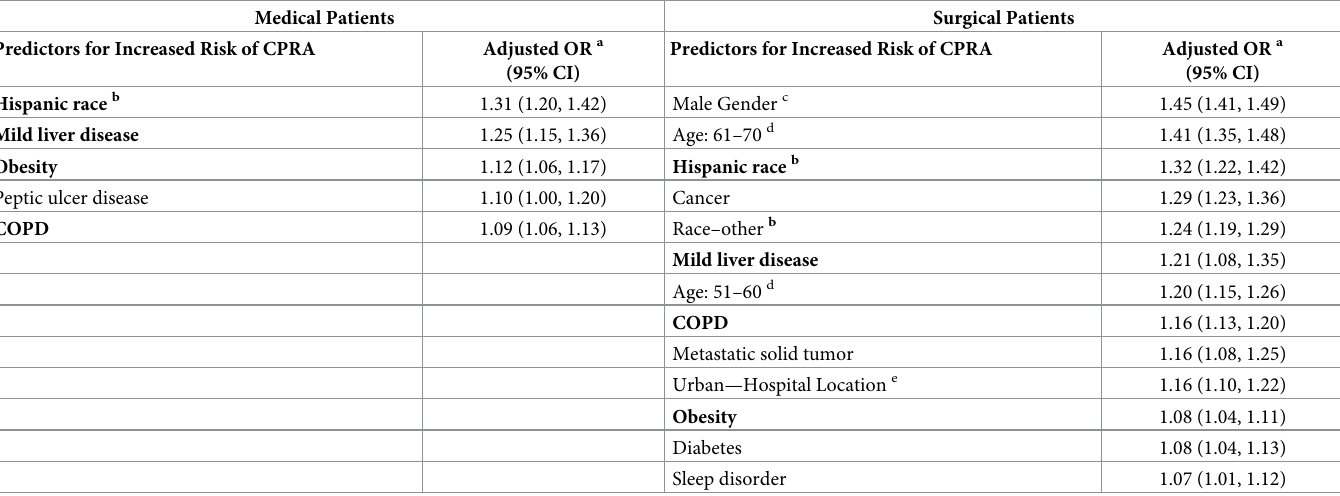
Table 3. Specific independent predictors of CPRA in medical vs. surgical patients on opioid and sedative